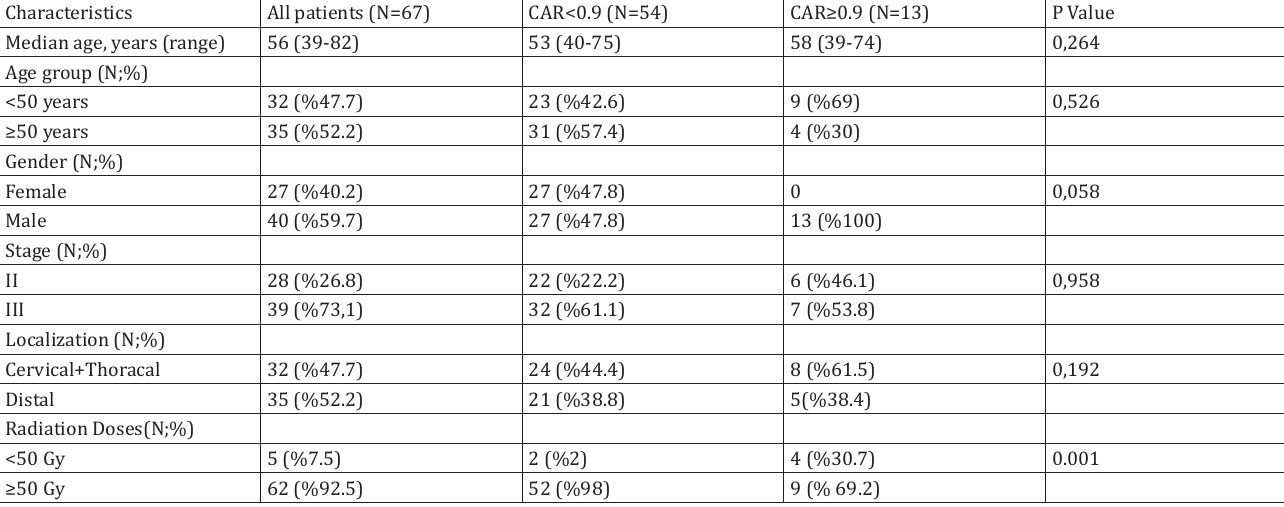
Abbreviations:OS: overall survival; HR: hazard ratio; C/T: cervical/ thoracal;